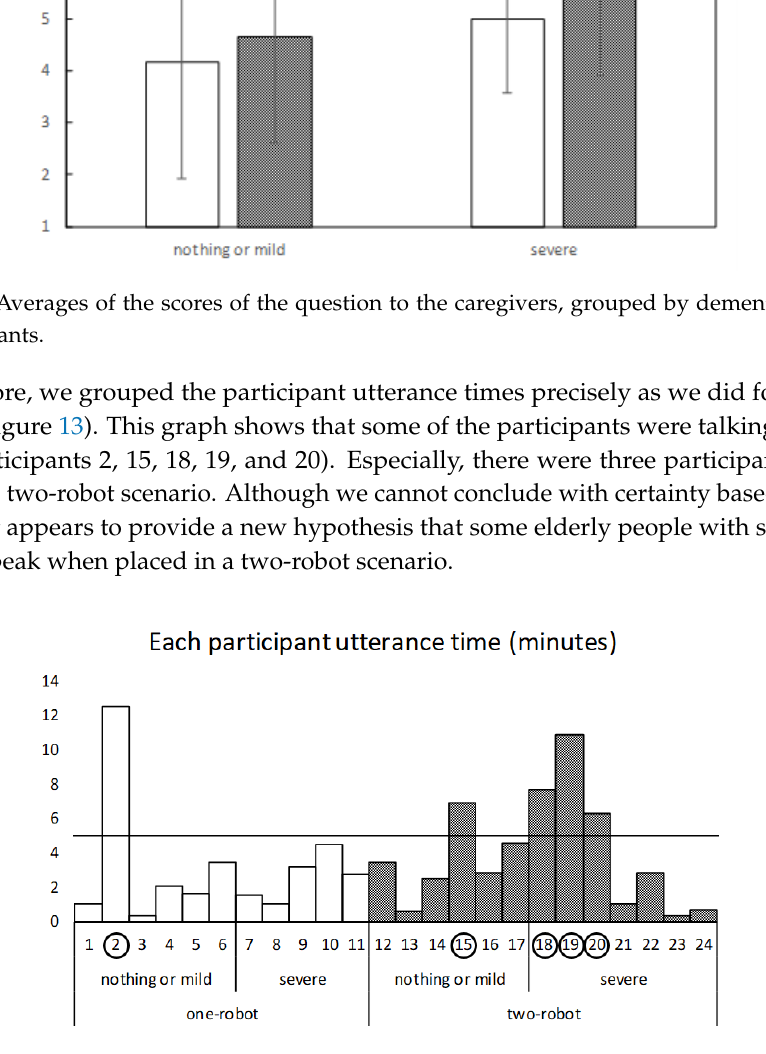
Figure 13. Utterance time of each participant grouped by dementia